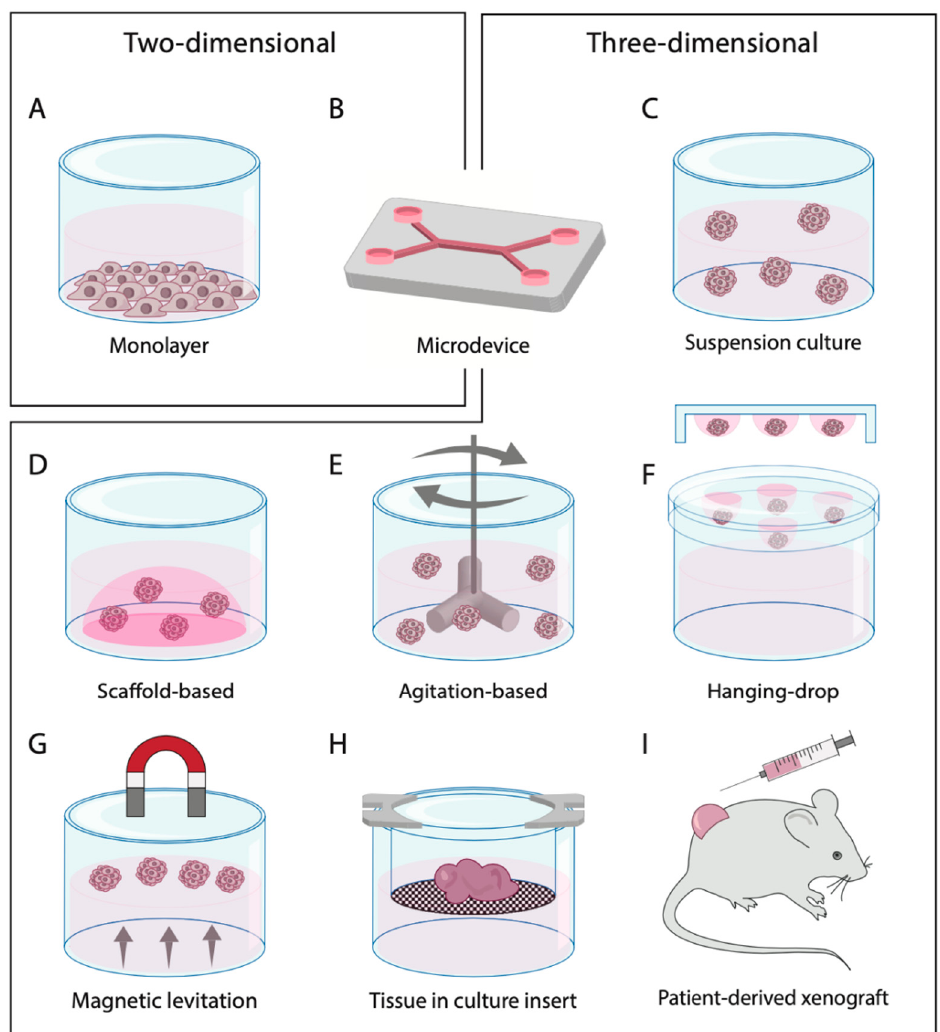
Figure 3. Primary cell culture techniques divided into two-dimensional and three-dimensional models. ( A ) 2D monolayer from single-cell suspension; ( B ) micro(fluidic) device; ( C ) spheroids in suspension culture; ( D ) spheroids embedded in a scaffold-based system; ( E ) spheroids in an agitation-based system, e.g., a spinner flask; ( F ) spheroids in hanging-drop cultures; ( G ) spheroids formed by magnetic levitation; ( H ) histoculture in culture insert; ( I ) patient-derived xenograft mouse model with subcutaneous injection. Image of xenograft was modified from Servier Medical Art (http://smart.servier.com/), licensed under a Creative Common Attribution 3.0 Unported License (https://creativecommons.org/licences/by/3.0/).